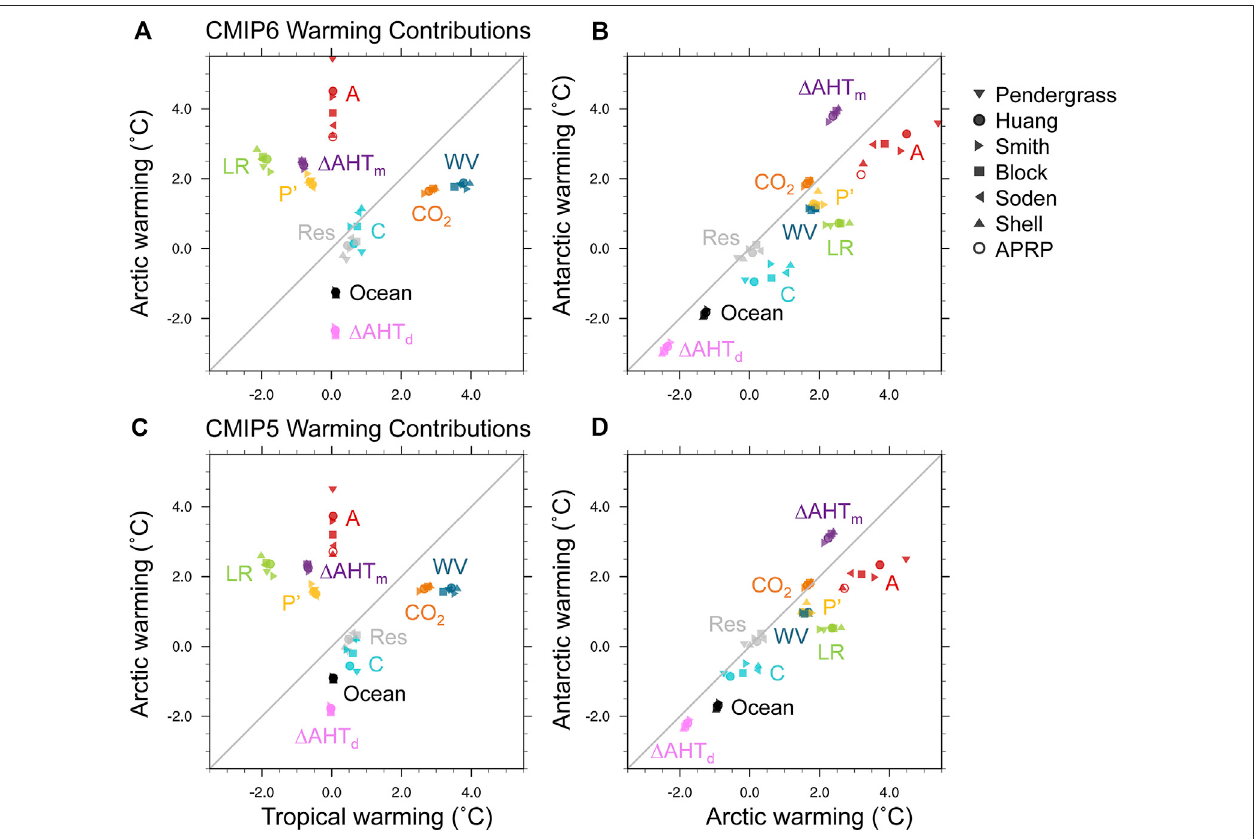
FIGURE5| Sensitivity ofwarming contributions( ˚ C) toradiative kernels in (A,B) CMIP6 and (C,D) CMIP5centeredaround year-100 ofabrupt CO 2 quadrupling for (A,C) the tropics relative to the Arctic and (B,D) the Arctic relative to the Antarctic. Warming contributions are shown for the lapse-rate (LR), surface albedo (A), water- vapor (WV), and cloud (C) feedbacks, the variation in the Planck response from its global-mean value (P ’ ), effective radiative forcing (CO 2 ), change in moist and dry AHT convergence( Δ AHT m ; Δ AHT d )andoceanheatuptake(Ocean),andresidualterm(Res).Thewarmingcontributionforthealbedofeedbackisadditionallycalculated using the APRP